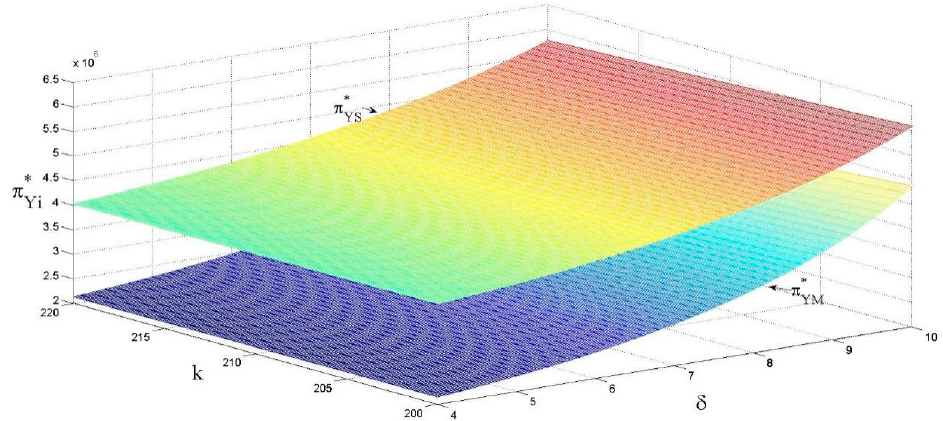
Figure 7. The effects of k and δ on the revenue in decentralized decision-making.